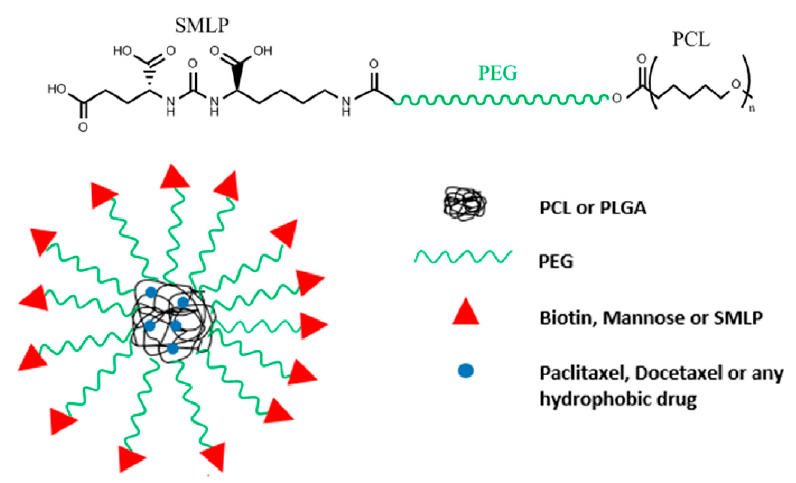
Figure 5. Chemical connectivity of PCL-PEG-SMLP nanoparticle design and nanoparticle design of those mentioned in Sections 2.1, 2.3 and